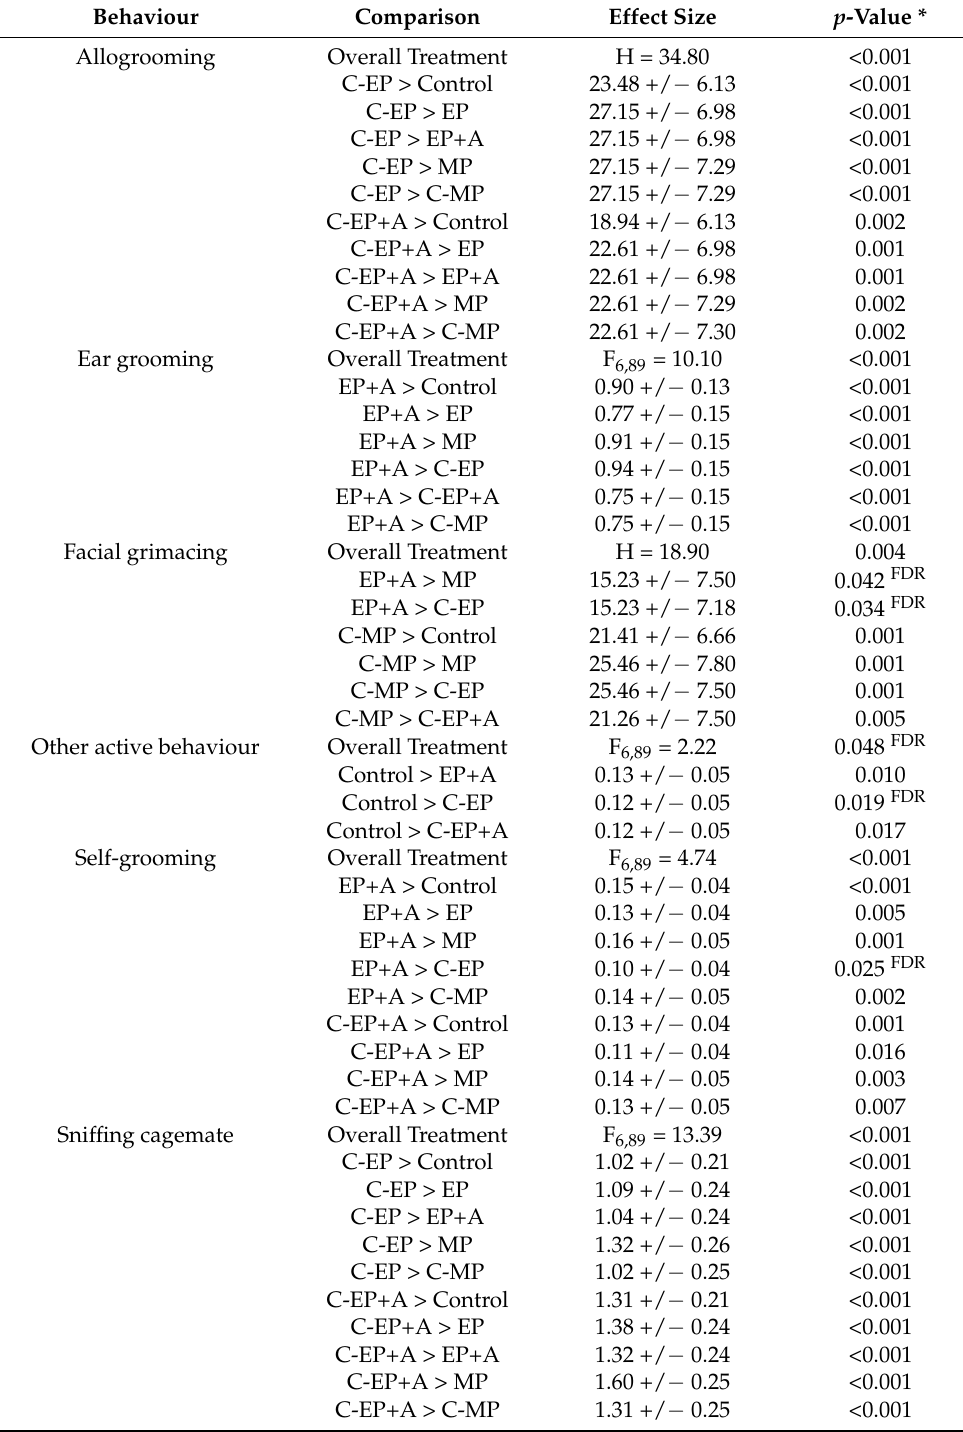
Table 3. Statistically significant effects and trends of identification marking methods on the homecage behaviour of mice and their